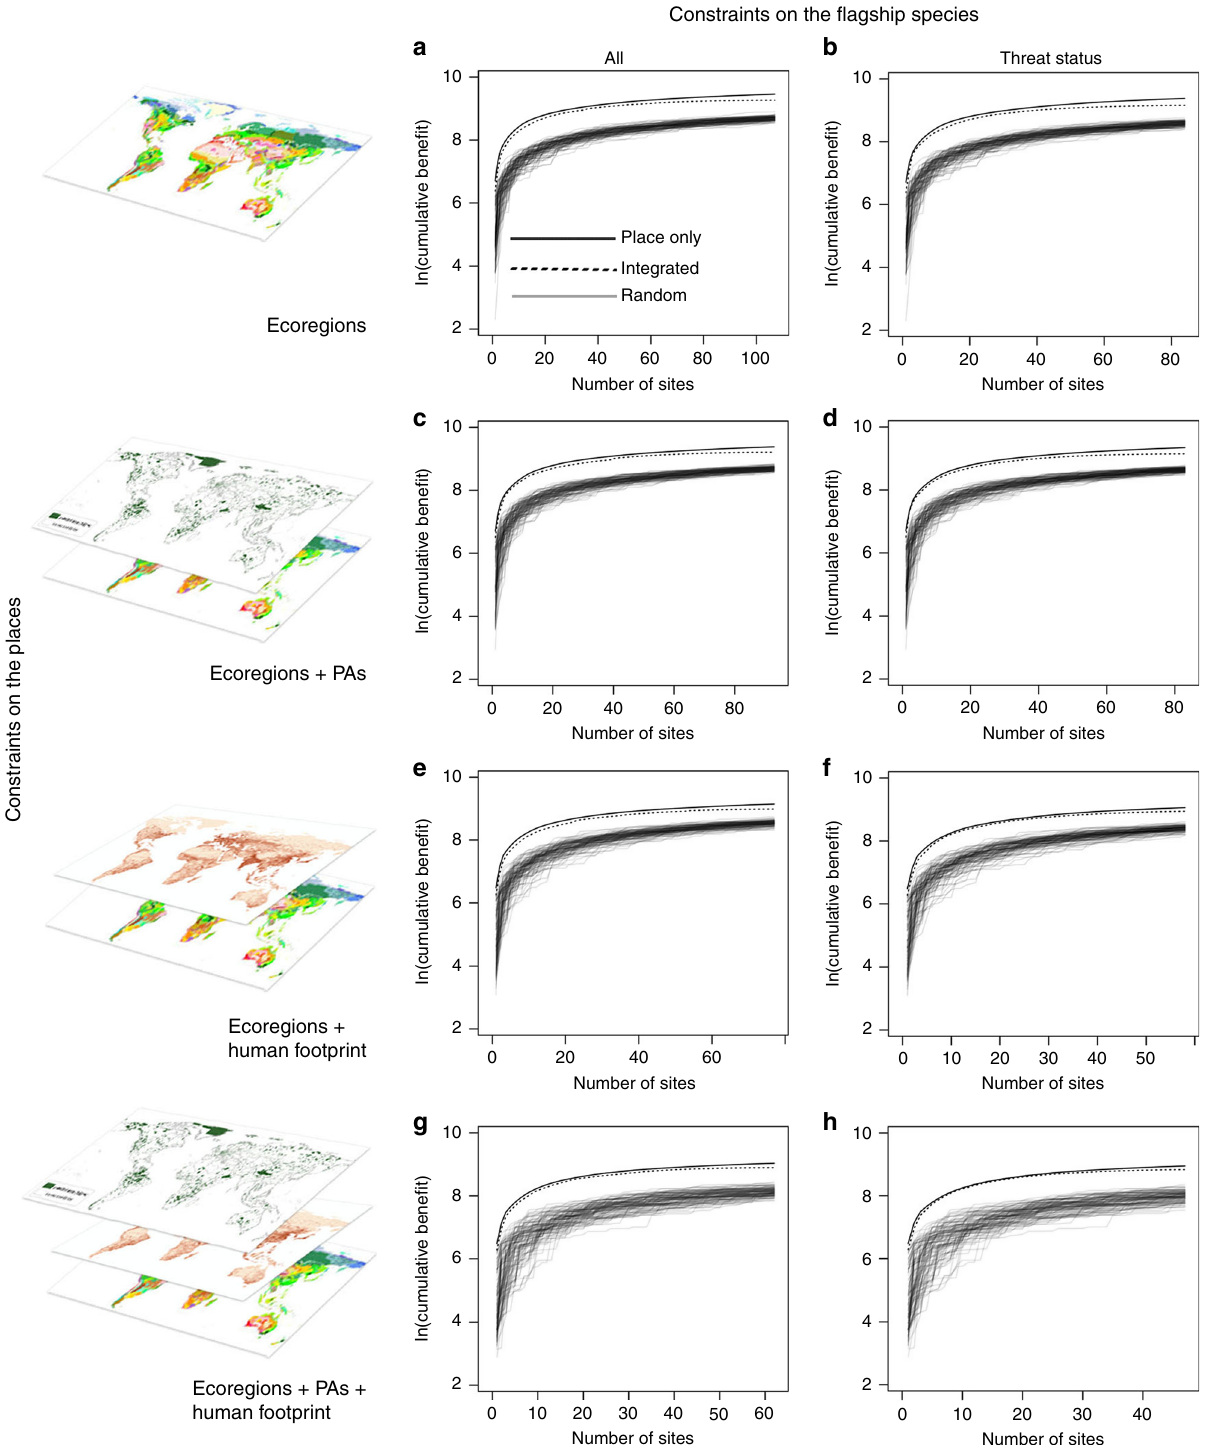
Fig. 1 Performance comparisons across scenarios. The scenario performance of the place-only, integrated, and random approaches ( a − h ) in achieving biodiversity representation (de fi ned as the number of background species protected). Random selections were performed 100 times for each scenario. Threat status refers to the candidate fl agship group subset by IUCN classi fi cation of Near-Threatened and higher. Source data are provided in the Source Data fi